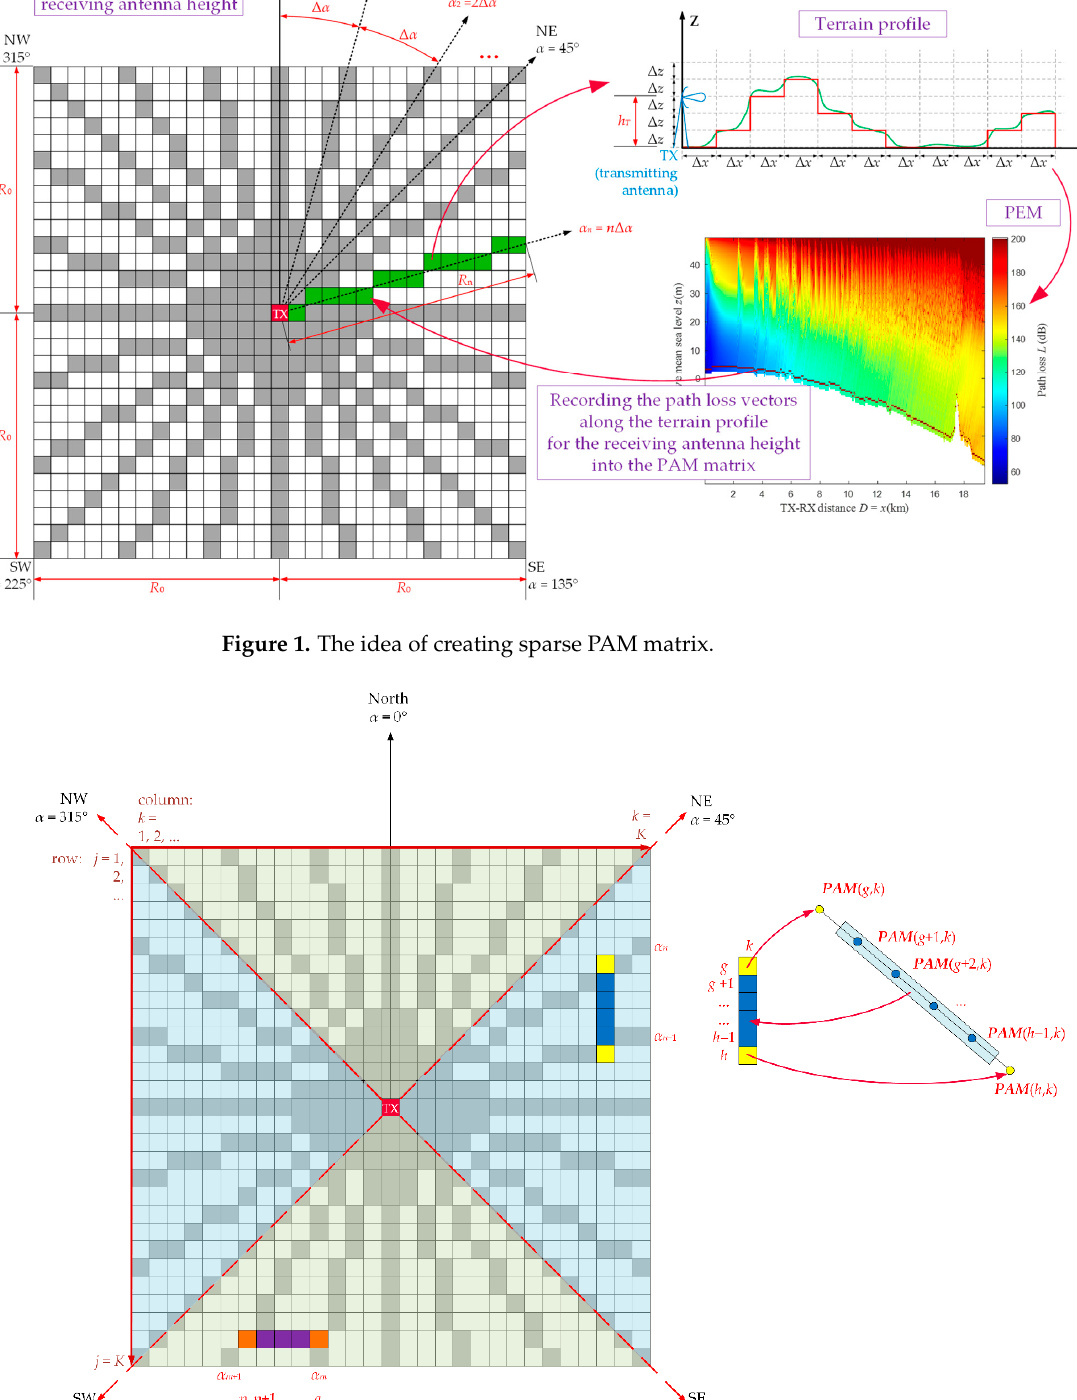
Figure 2. Interpolation method for creating full PAM matrix.